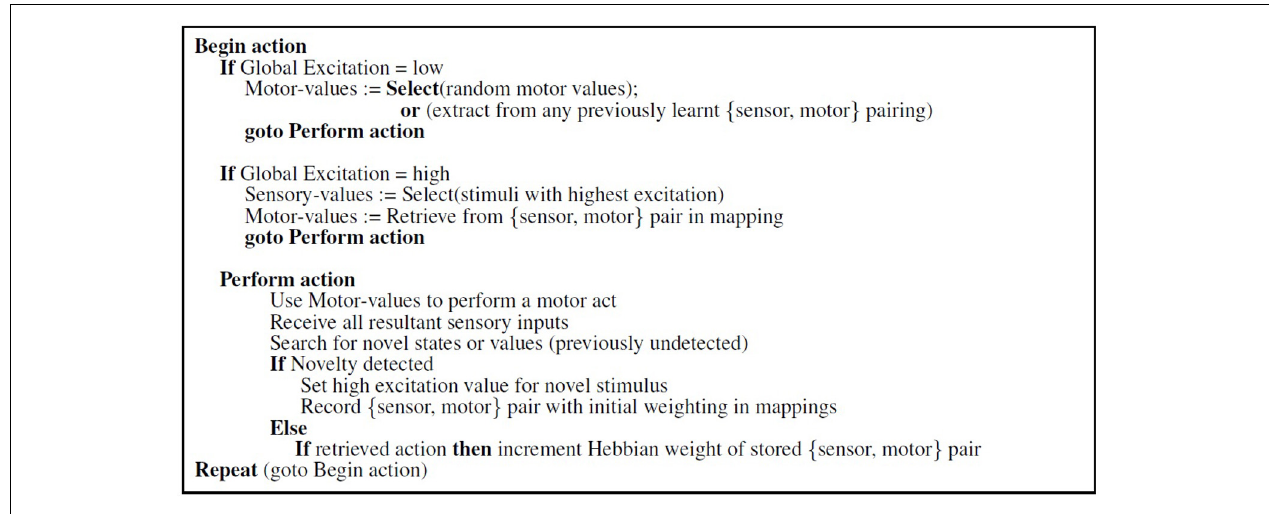
FIGURE 3 | Algorithm for novelty-driven action selection (derived from experiments in Law et al., 2011).